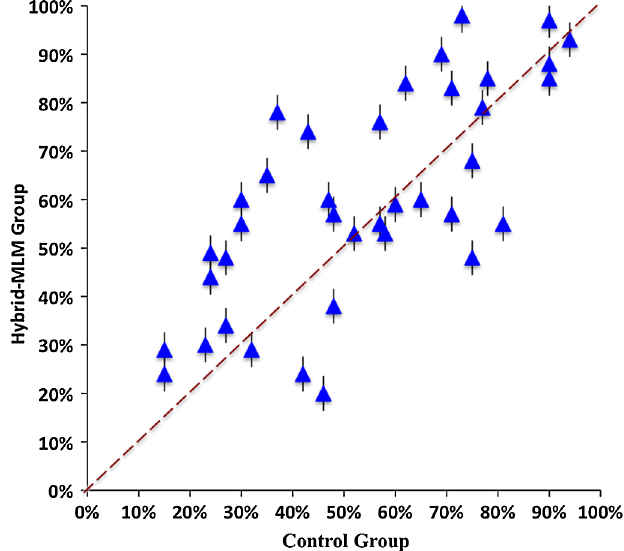
FIG. 3 (color online). Scatter plot of student correct responses to 38 identical clicker questions in control and hybrid-MLM classes. Each point represents one clicker question where the average correct responses for the control group and hybrid-MLM are on the x and y coordinates, respectively. The error bars represent the standard error for each question and the dashed line represents the x ¼ y